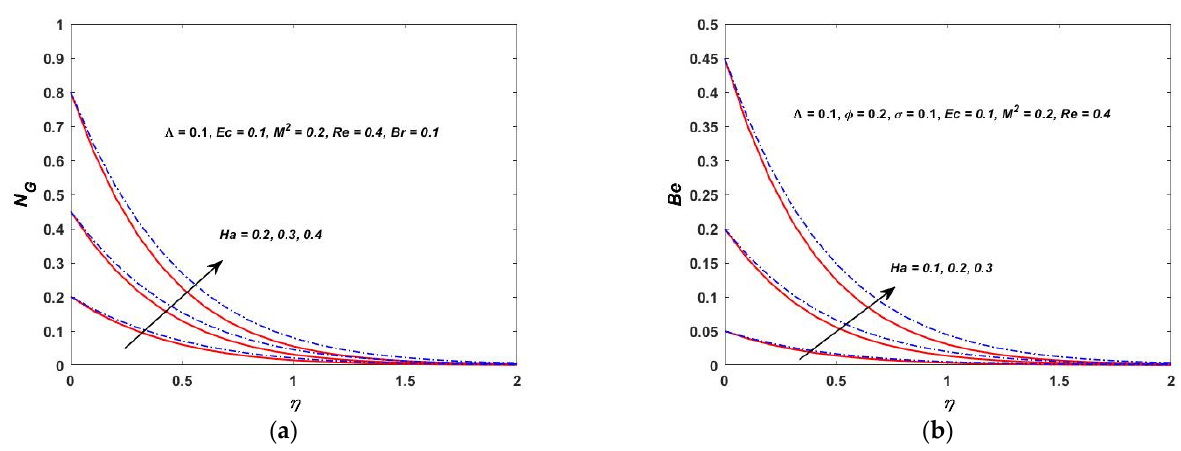
Figure 26. ( a ) Hartmann verses entropy 𝑁 (cid:3008) . ( b ) Hartmann verses Bejan (Be).